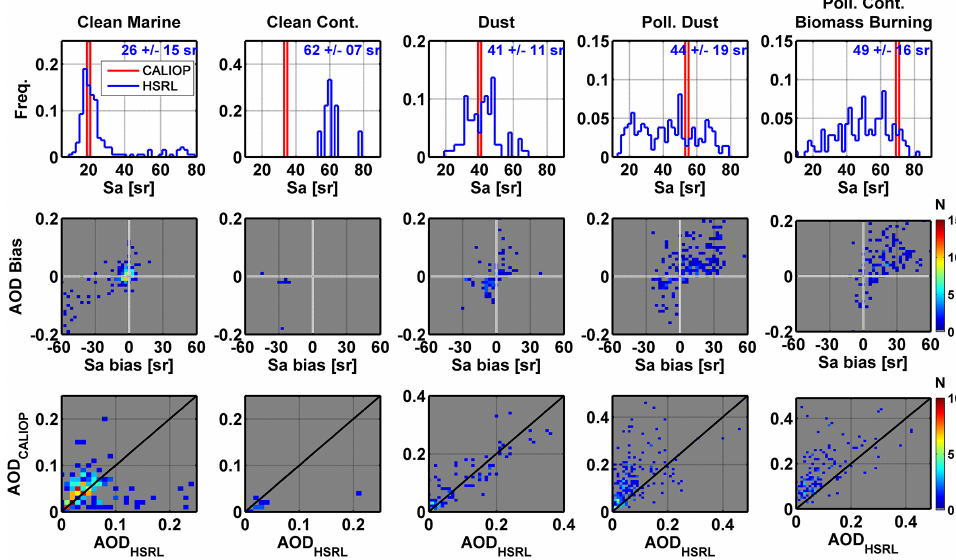
Figure 11. Daytime histograms of lidar ratio (top row), AOD bias (CALIOP – HSRL) vs. Sa Bias (CALIOP – HSRL) (middle row), and AOD (middle row) with AOD scatterplots (bottom row) for each CALIOP aerosol type (columns). The numbers in the top row are the means and SDs of the lidar ratios measured by the HSRL.